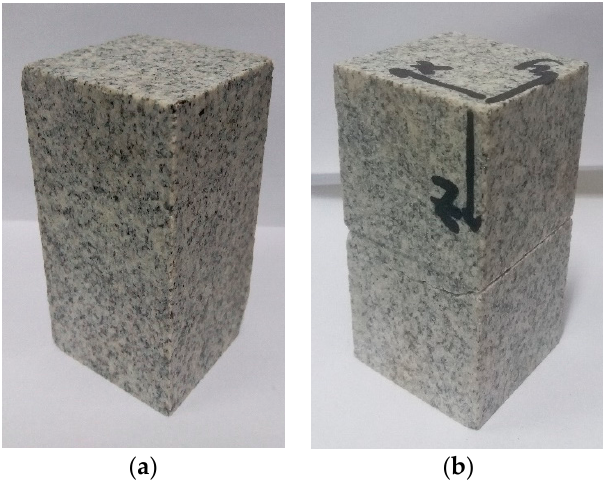
Figure 1. The granite samples. ( a ) in intact state, ( b ) in split state. Table 1. The composition of granite.